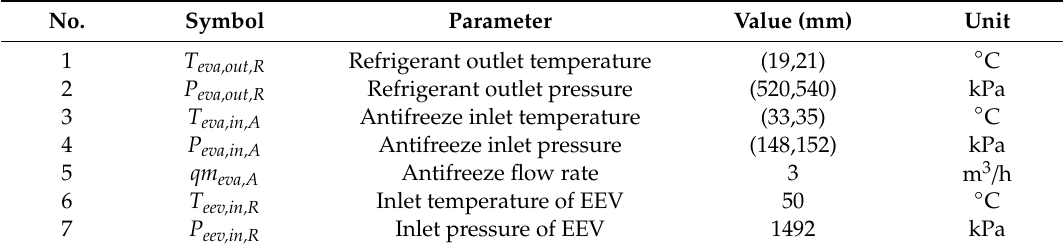
Table 5. Experimental conditions of evaporator.